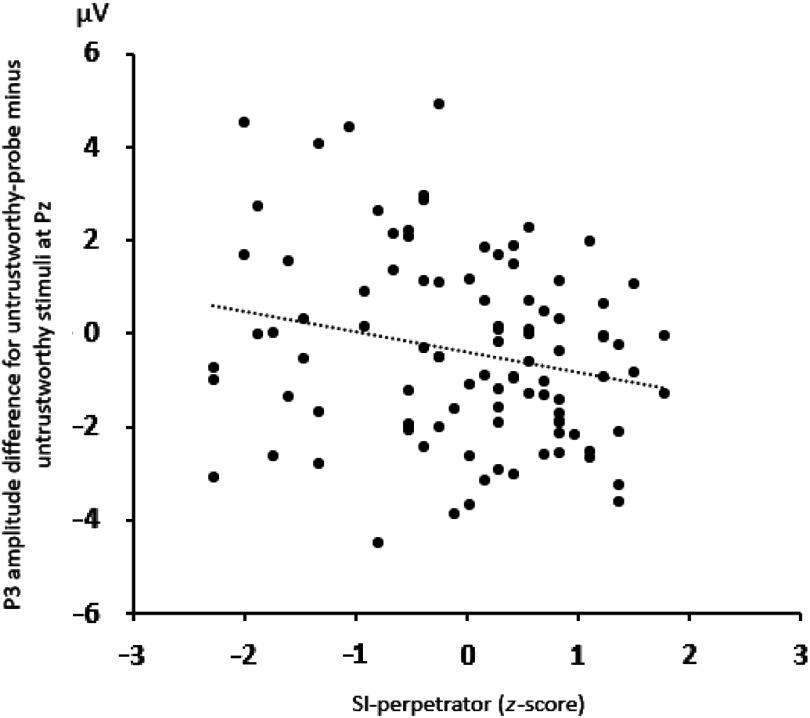
Scatterplot of the mean P3 amplitude differences for untrustworthy-probe minus untrustworthy stimuli and the SI-perpetrator z-scores. A high SI-perpetrator z-score means that the corresponding individual is in particular sensitive to injustice that she/he provides to others.